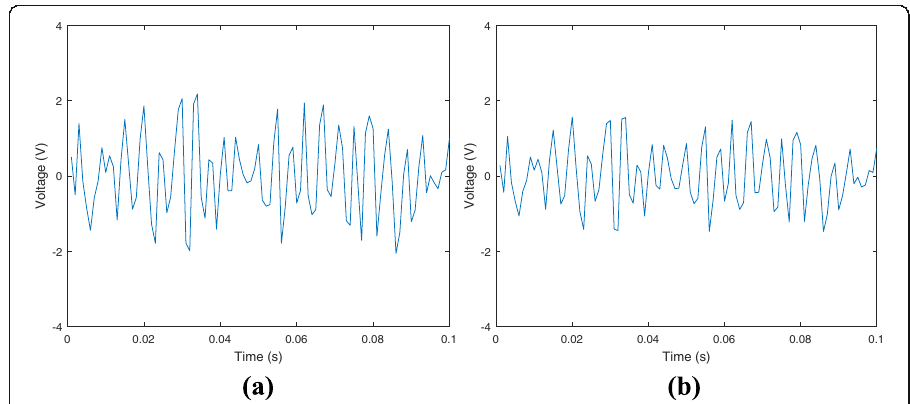
Fig. 3 Echo voltage. a Horizontal polarization echo voltage. b Vertical polarization echo voltage